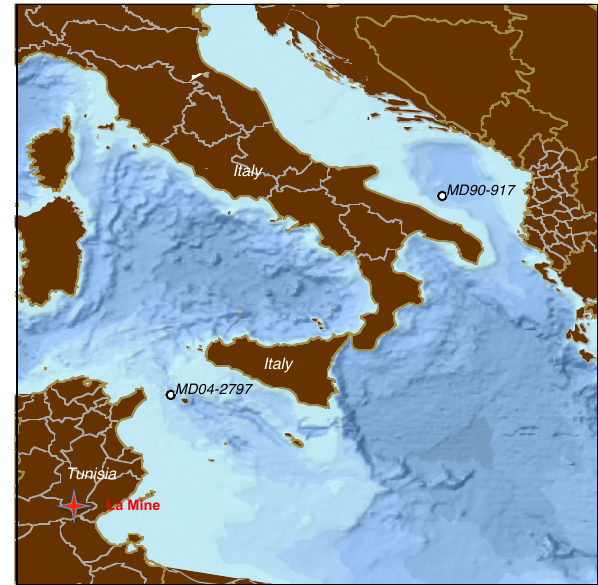
Fig. 1. Map showing the location of the two study cores of the Central Mediterranean Sea: MD90-917 (South Adriatic Sea) and MD04-2797 (Siculo–Tunisian Strait). The red star indicates the lo- cation where the La Mine stalagmite has been